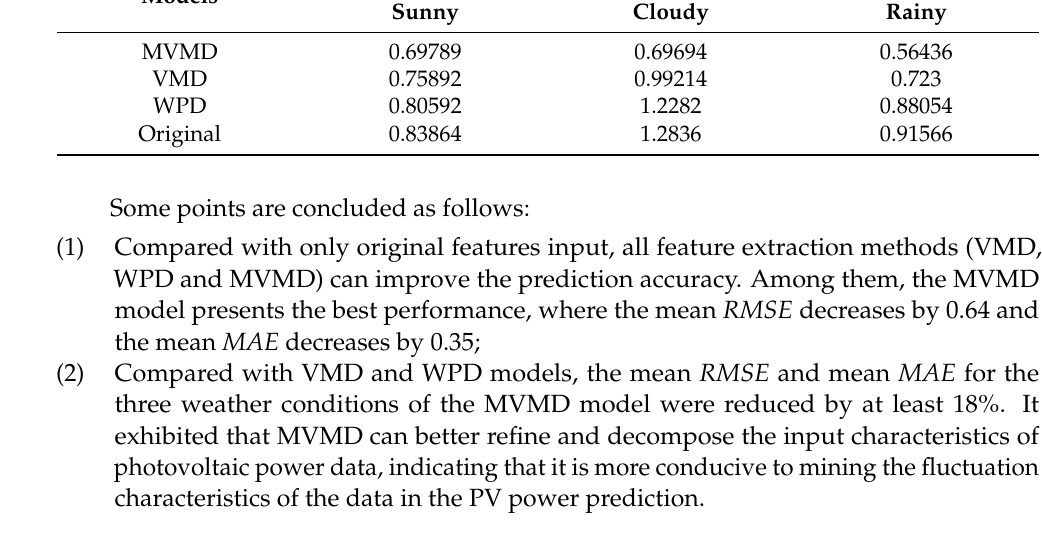
Table 6. MAE of each model under different weather conditions.